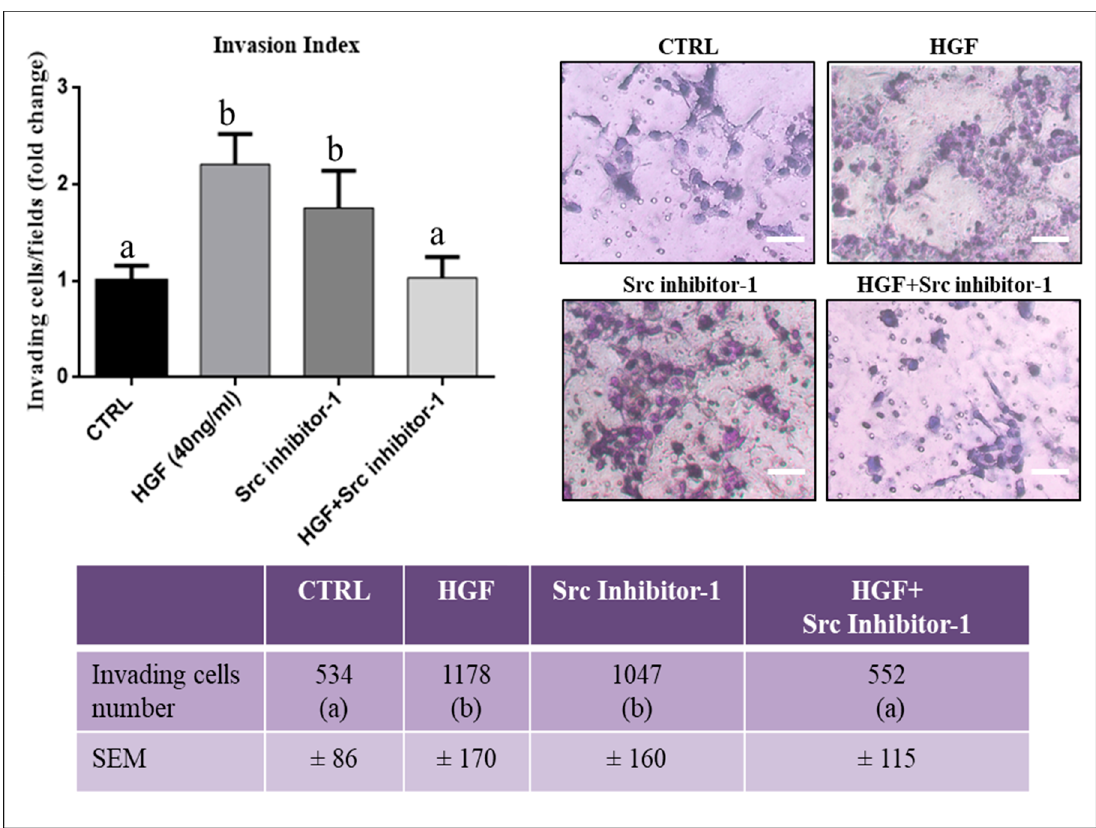
Figure 6. Effect of Src Inhibitor-1 on NT2D1 cell invasiveness: Invasion assay was performed using filters coated with GFR-Matrigel. The filters were analyzed by optical microscope. Three independent experiments were performed at least in triplicate. Left panel: Quantitative analysis of invading cells. The results are expressed as fold-change (± SEM) and the control condition has been arbitrarily considered as 1. Both HGF and Src inhibitor-1, administered alone, induce a statistically significant increase of NT2D1 cell invasion with respect to control samples (b vs a, p < 0.05). The co-administration of HGF+ Src inhibitor-1, abrogates the HGF-dependent NT2D1 cell invasion. Right panel: Representative bright-field microscopy images of the different culture conditions (scale bar: 70 µm). Images demonstrate a higher invasive behaviour of cells treated with HGF or Src inhibitor-1 alone compared with HGF + Src inhibitor-1 or control conditions. The table in the lower panel illustrates the real number of invading cells/filter in all the experimental conditions reported in the respective “fold change” graph (b vs a, p < 0.05).